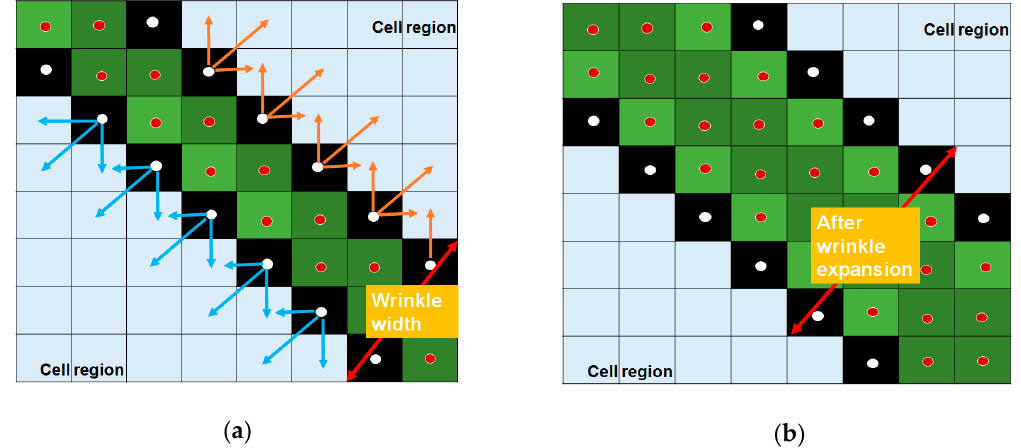
Figure 6. Wrinkle width expansion—( a ) before wrinkle width expansion; ( b ) after wrinkle width expansion.